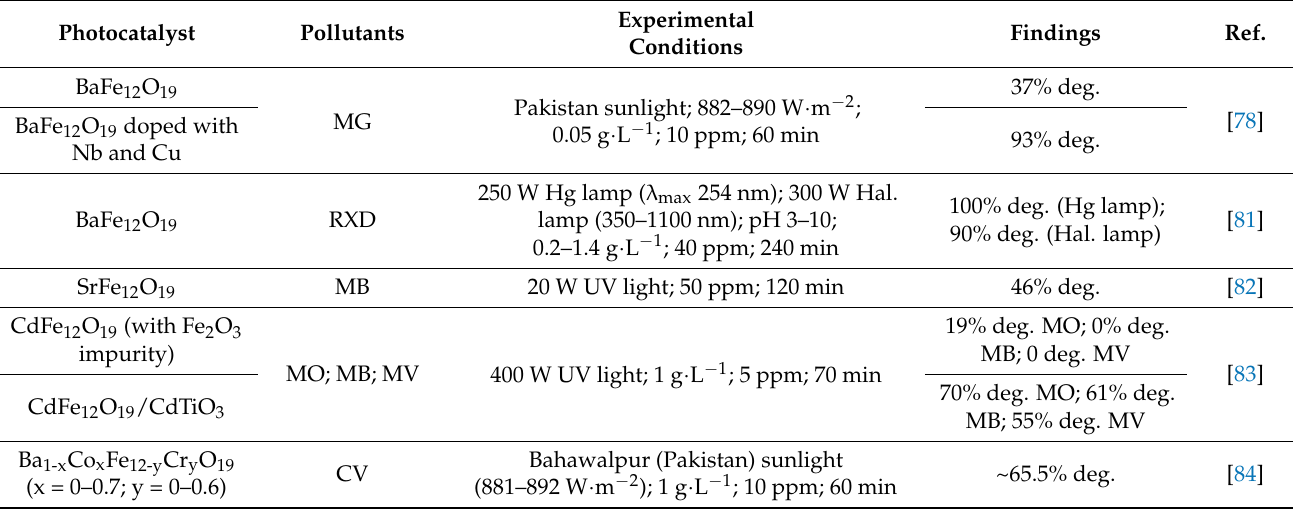
Table 2. Summary of M-type hexaferrite